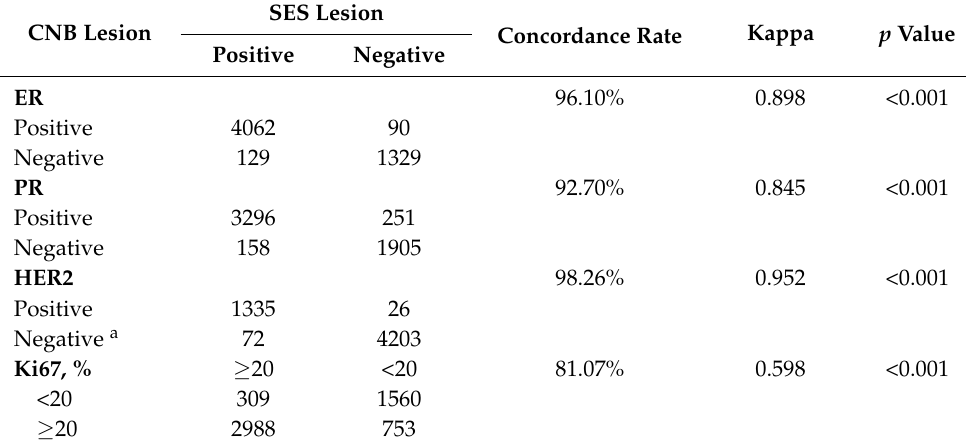
Table 2. Concordance rate of biomarker status between CNB and SES